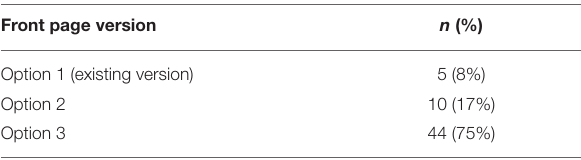
TABLE 2 | N (%) of sample selecting each option as their preferred version of the front